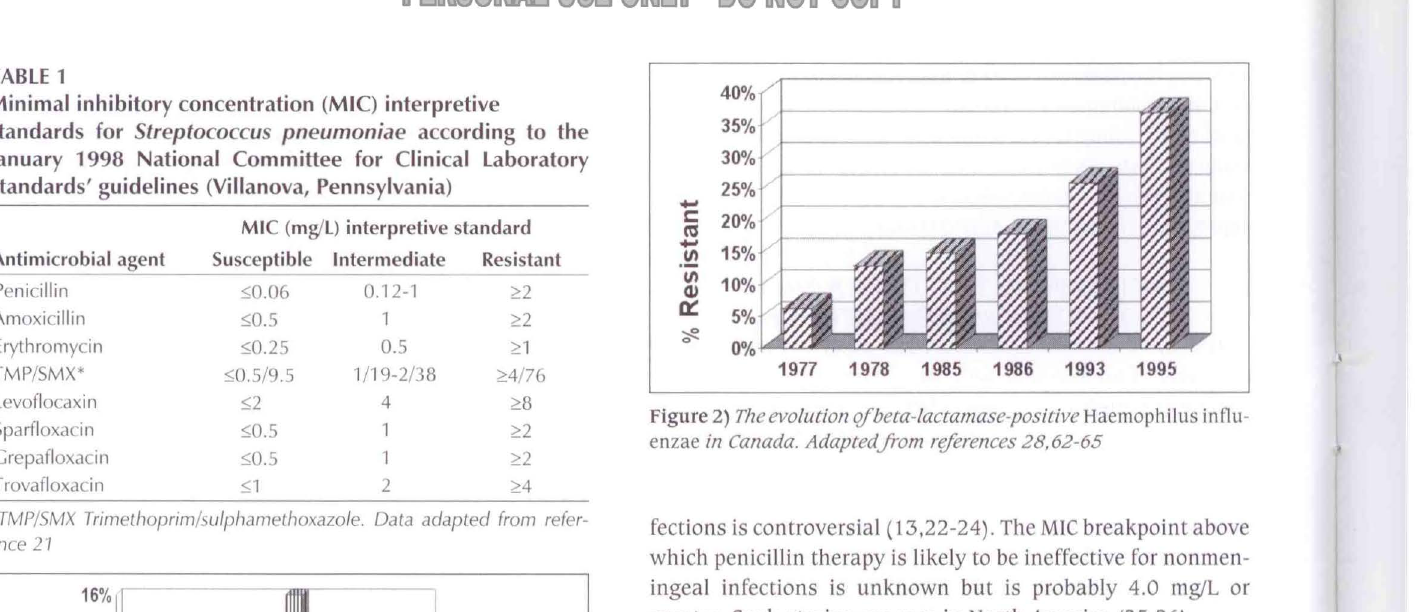
fections is controversial ( 13,22-24). The MIC breakpoint above which penicillin therapy is likely to be ineffective for non men ingeal infections is unknown but is probably 4.0 mg/L or greater. Such strains are rare in North America